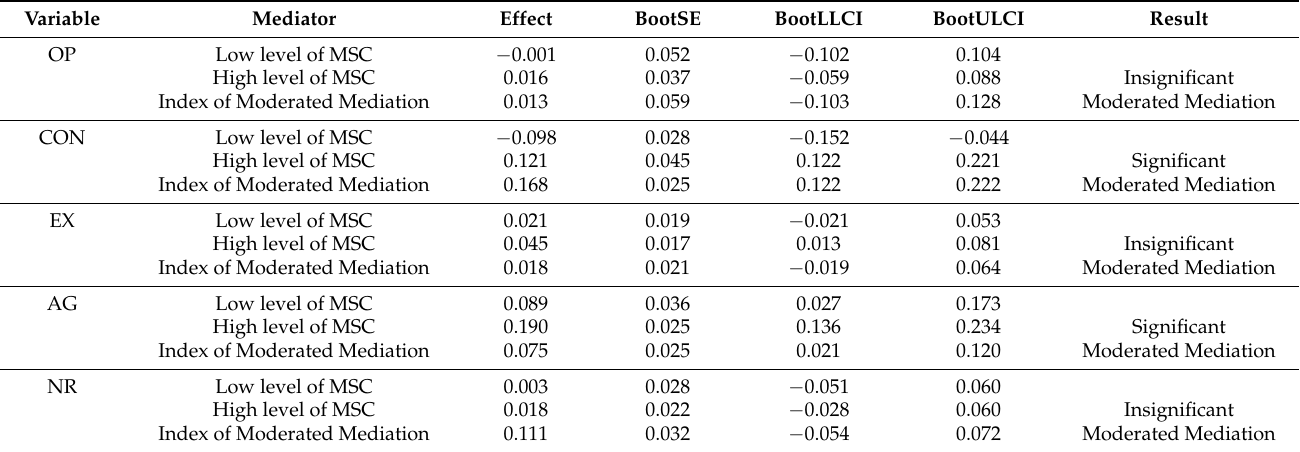
Table 6. Results of Moderated Mediation